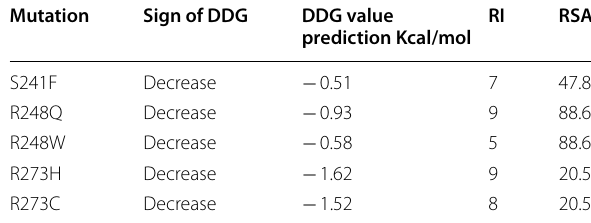
Table 9 I-mutant predictions for selected nsSNPs Mutation